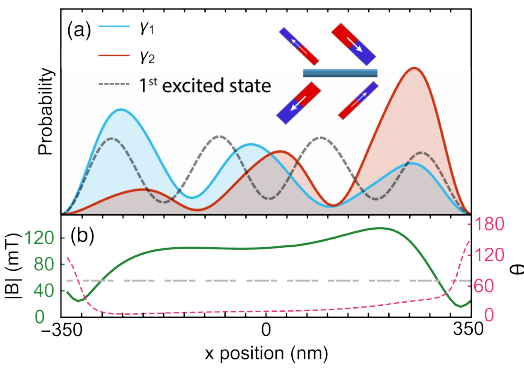
Figure 3: (a) Probability distributions for two Majorana wavefunctions γ The first excited state (dashed line) is a bulk nanowire state. (b) Magnetic field profile reproduced from Fig. 2 over a smaller range. Hard boundaries are